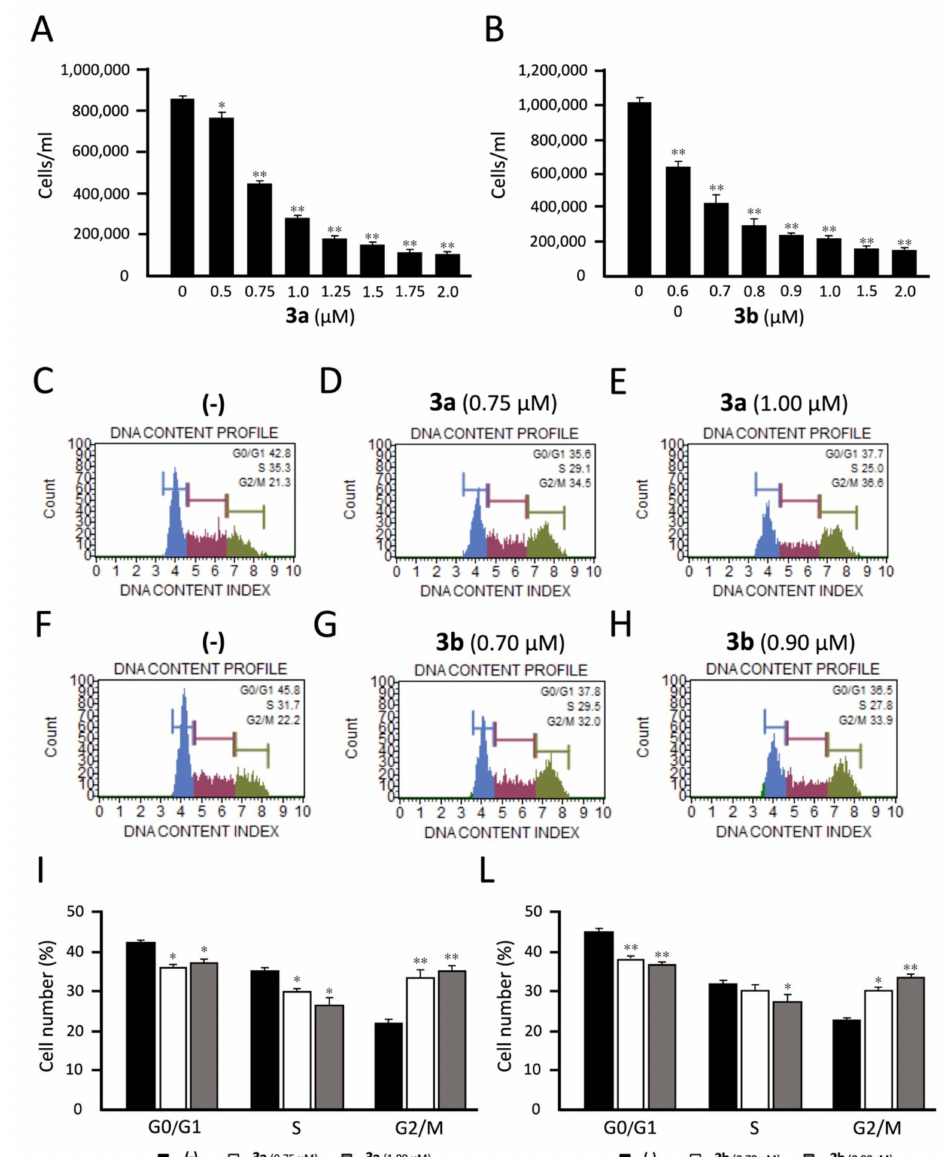
Figure 2. E ff ects of the tetrahydrothieno[2,3- c ]pyridines 3a and 3b on cell growth and cell cycle. K562 cells were treated with compounds 3a ( A,C – E,I ) and 3b ( B,F – H,L ) and the following biological parameters were evaluated: cell growth ( A,B ) and cell cycle distribution ( C – H ). Analyses were performed after 3 days of cell culture at the indicated concentrations of the compounds. In panels C-H, representative cell cycle analyses are reported. In panels I and L, a summary of three independent experiments is reported. The data represent the average ± S.D. *: significant ( p < 0.05); **: highly significant ( p <